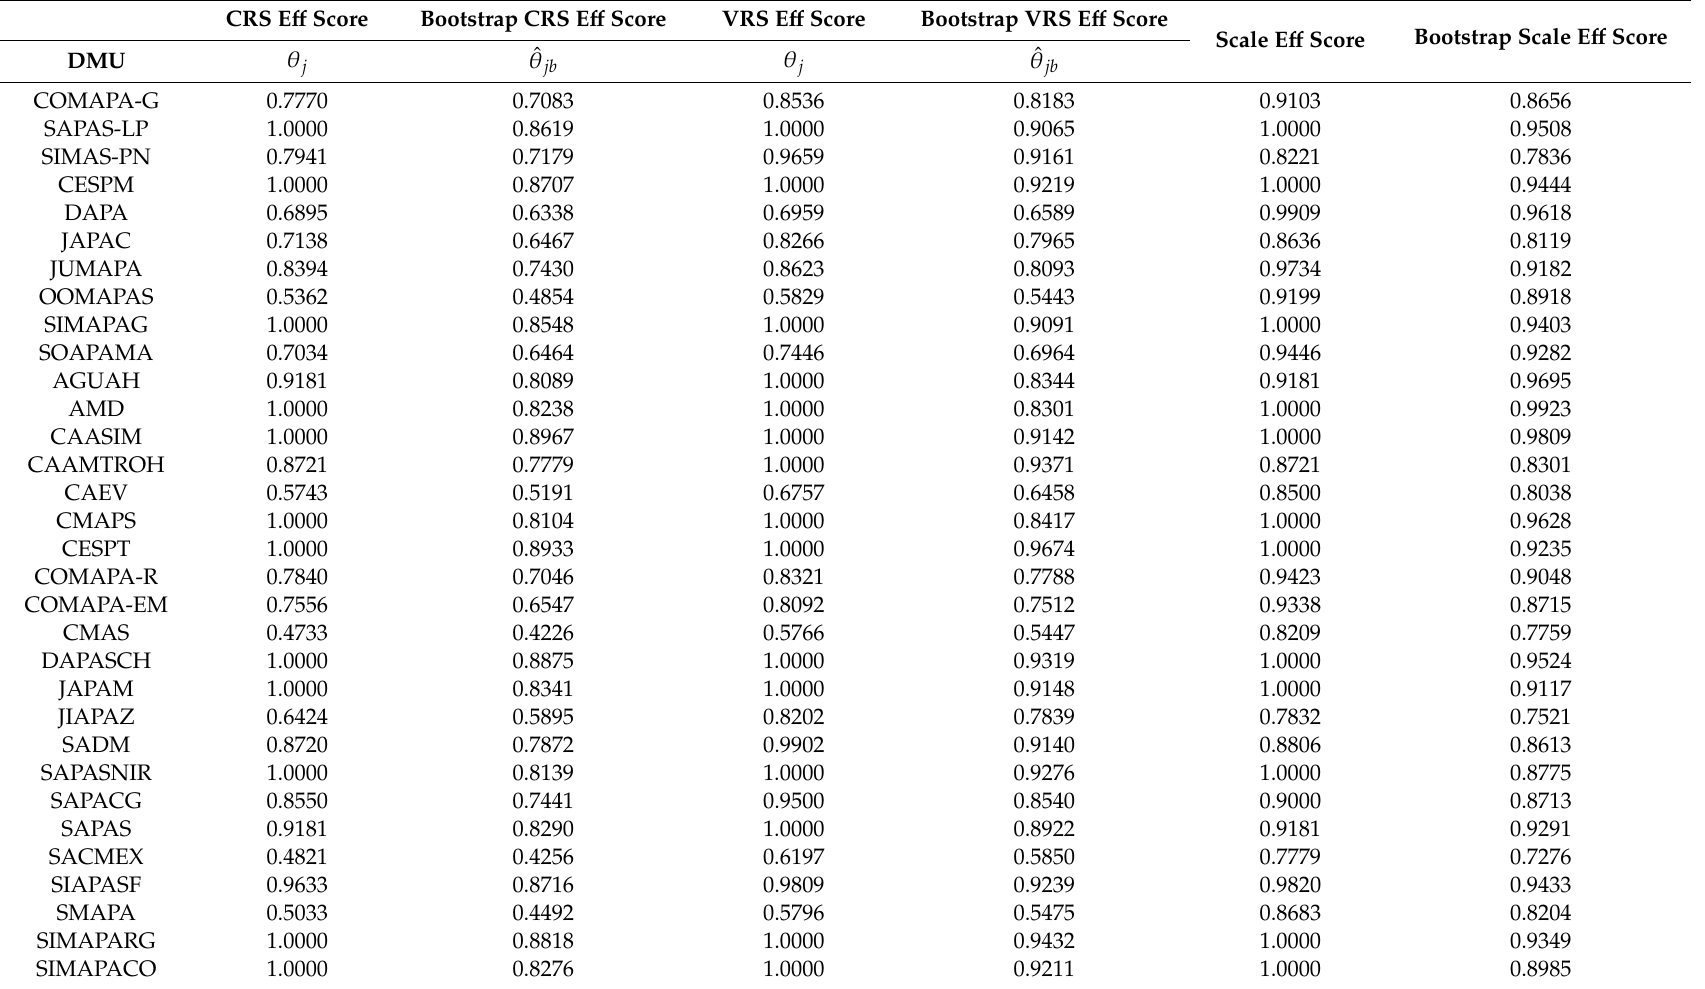
Table 9. E ffi ciency and Bootstrap E ffi ciency